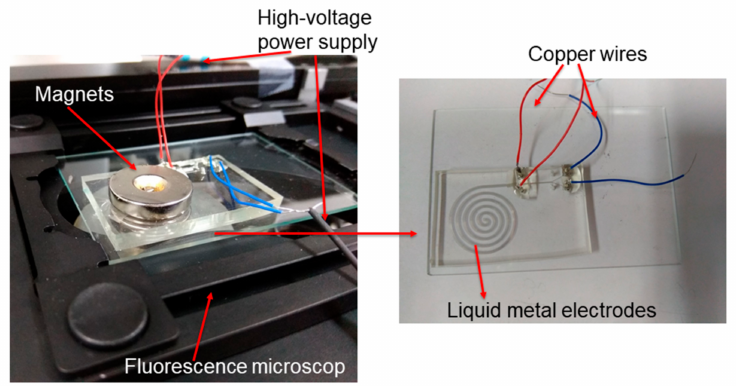
Figure 3. Experimental set-up for measurement of the pumping velocity of the liquid-metal-based MHD